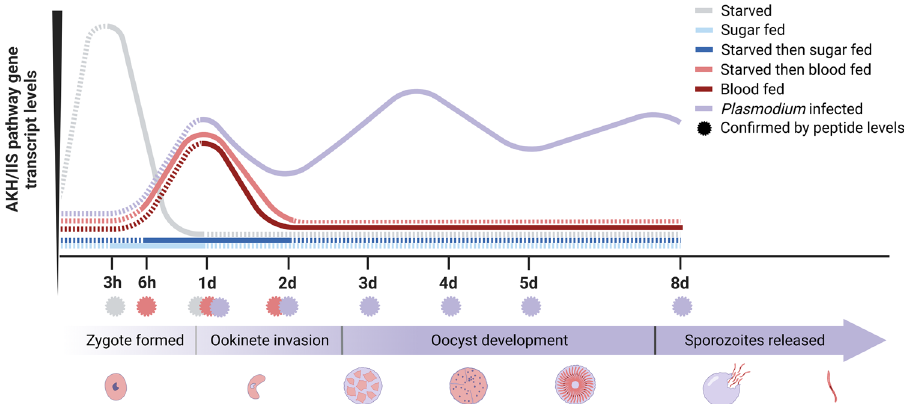
Fig. 5 Graphical representation of measured AKH/IIS pathway gene transcript levels across time and experimental conditions. AKH/IIS pathway gene transcript levels increase in starved (light gray) conditions between 3 and 6 hours, as veri fi ed by AgAkh1 peptide titers (light gray asterisks), in comparison to the sugar-fed condition (light blue). Between 6 and 48 hours, the starved then blood-fed treatment (light red) increases in AKH/IIS pathway gene transcript levels, as veri fi ed by peptide titers at these timepoints (light red asterisks), in comparison to the starved then sugar-fed group (dark blue). AKH/ IIS pathway gene transcript levels increase from 3 – 8 days in the Plasmodium-infected blood-fed condition (purple), with spikes coinciding with oocyst development and sporozoite release (pictorially represented under the purple Plasmodium development arrow) and veri fi ed by peptide titers (purple asterisks), in comparison to the blood-fed only samples (dark red). Proposed but not measured trends for each condition are displayed as color-matched dashed